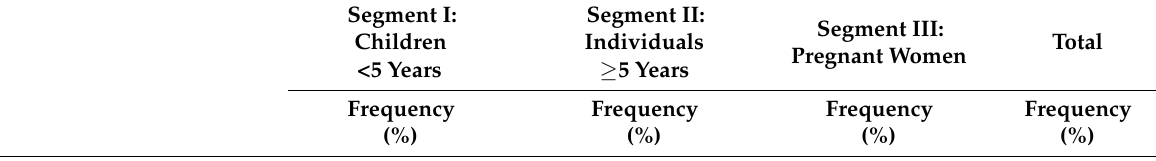
Table 2. HW compliance with MFT strategy guidelines and patient adherence to ACT